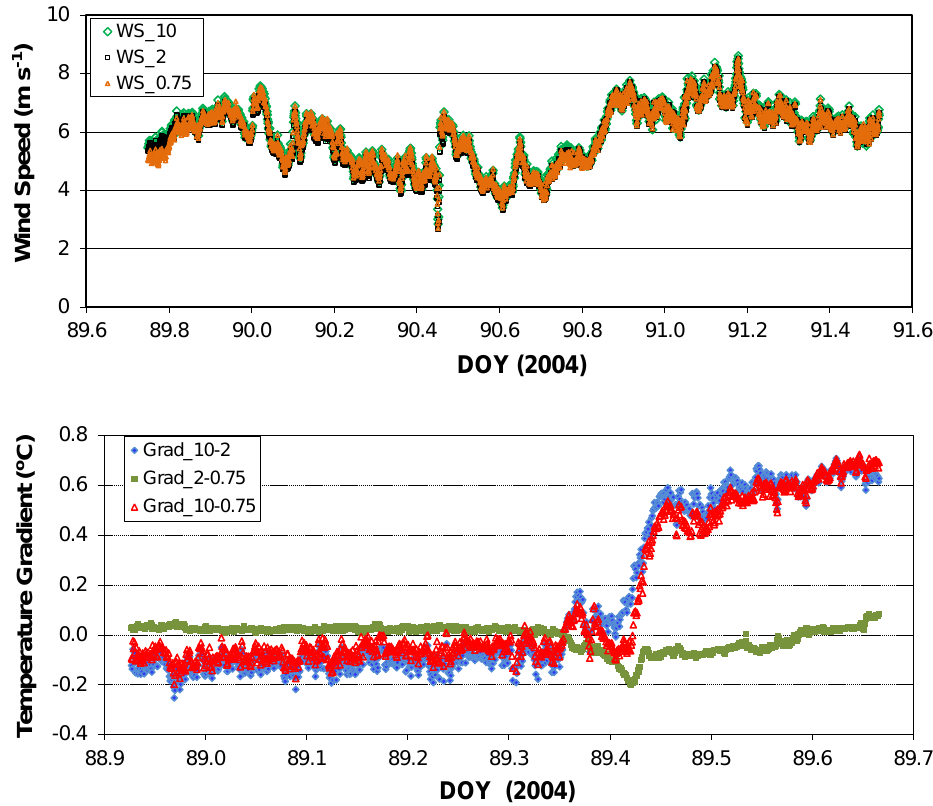
Fig. 5. Example of results from the inter-comparison measurement during DOY 89-91 (29–31 March) (upper graph) and DOY 89 (29 March) (lower graph), where the three instruments were brought to the same height and run side by side. The upper graph shows ∼ 1day of wind speed data from the three cup anemometers prior to being subjected to correction functions. WS 10, WS 2, and WS 0.75 refer to the instruments that were operated at the 10m, 2m and 0.75m height, respectively. Deviations in data between the sensors were on average less than 2%, almost indiscernible in this plot. The bottom graph shows the raw, uncorrected data from the inter-comparison of the temperature sensors. Gradients were determined directly. For example, “Grad 10-2” stands for the gradient measurement between the 10- and the 2-m measurement height. Deviations from zero are due to instrument noise and measurement artifact (see discussion in Sect.